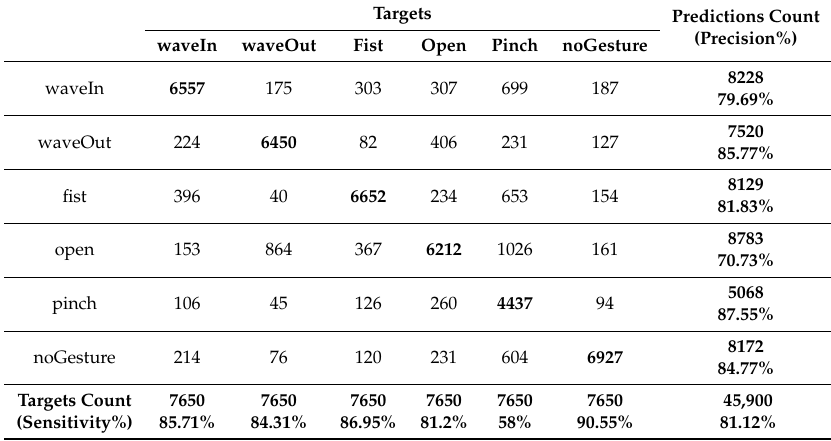
Table A17. Confusion matrix for experiment 3 . Synchronization gestures ( sync = 3 ) .